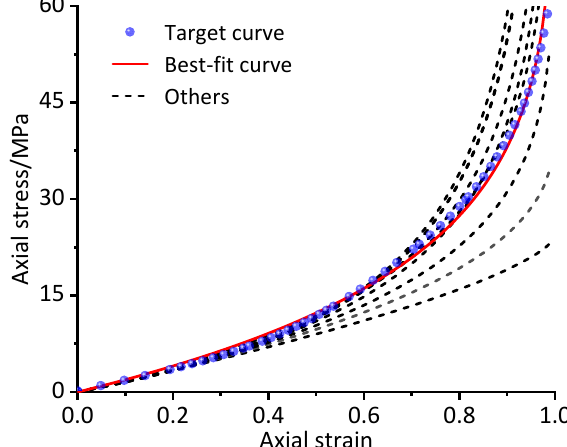
Figure 7. Approximating to a single stress ‒ strain curve.